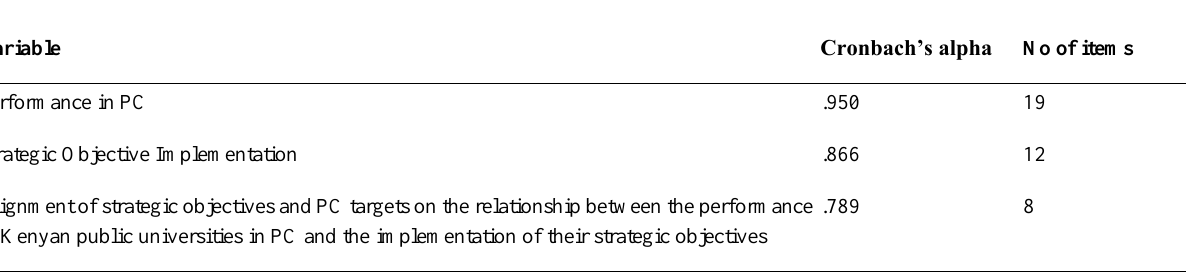
Table 1: Reliability Analysis